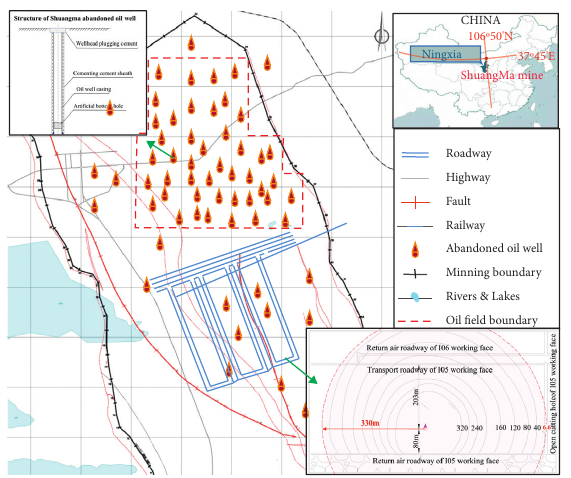
Figure 1: Oil and gas reservoir disasters in working face of Shuangma coal